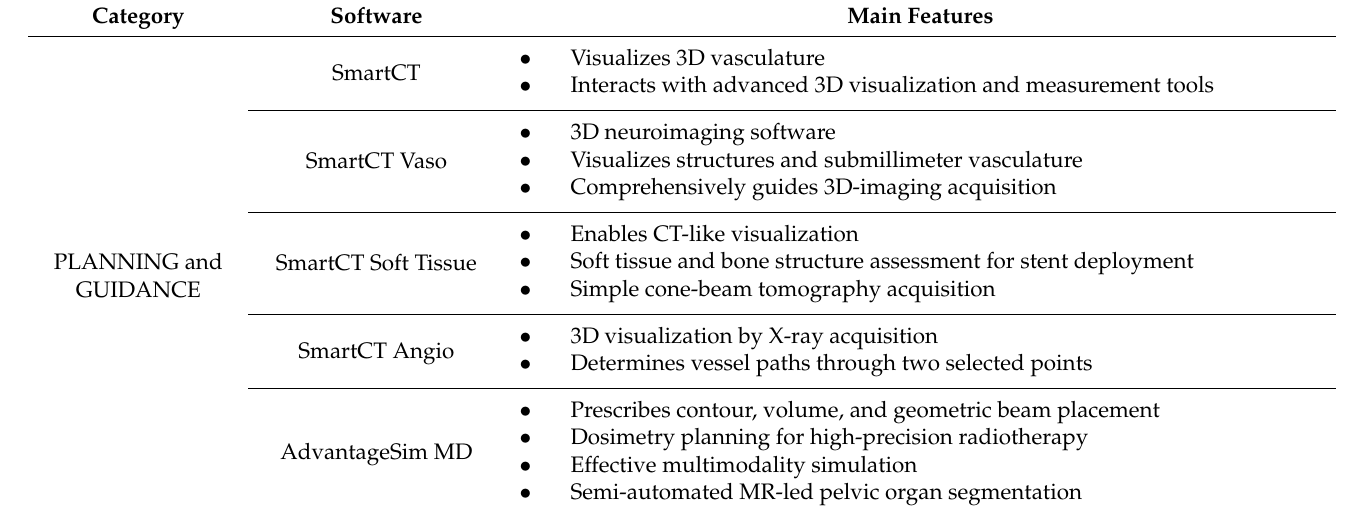
Table 1. Summary of commonly available (Planning and Guidance) procedural software used in interventional